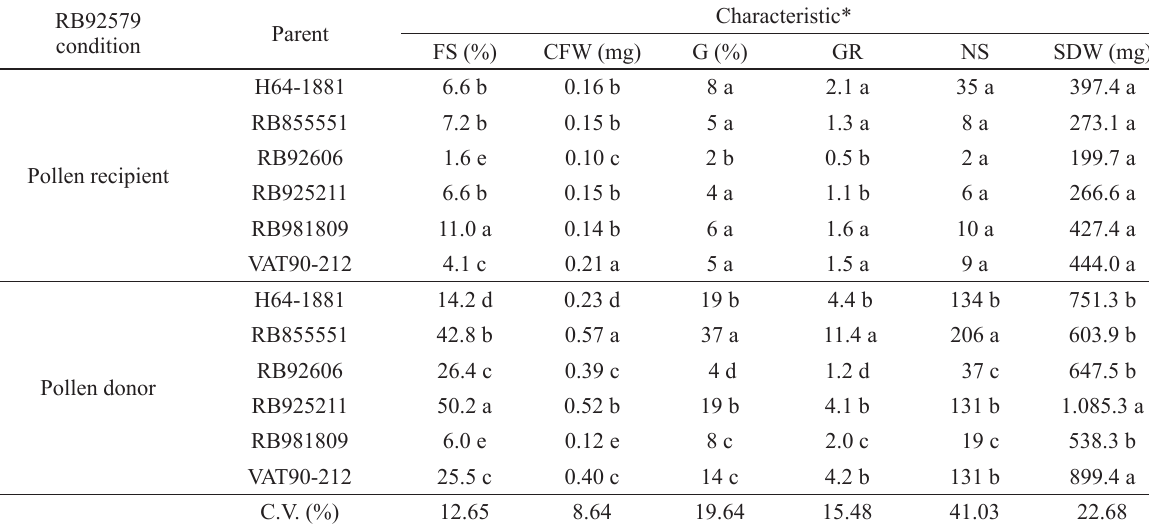
Percentage of fertile spikelets (FS), caryopsis fresh weight (CFW), germination (G), index of germination rate (GR), number of normal seedlings per gram of fuzz (NS), and seedling dry weight (SDW) from different hybridizations among RB92579 (pollen recipient or pollen donor) and other six sugarcane